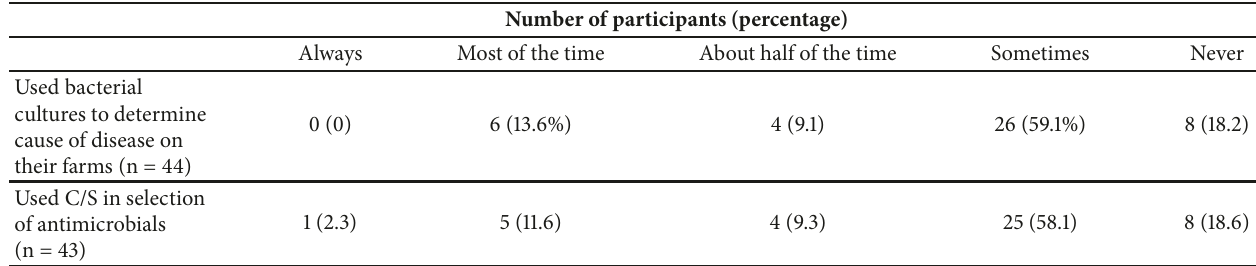
Table 2: Survey results showing the practices of Tennessee dairy producers related to antimicrobial use, 2018. Practice Farm keeps up-to-date written records of antimicrobial drug purchases (n = 40) Farm keeps written records of medicated feeds purchased in the framework of VFD (n = 40) Farm keeps up-to-date written records of antimicrobial drugs used to treat animals (n = 40) Cattle on the farm are sometimes treated with antimicrobials at dosages higher than the label provision (n = 40) Farm practices extra-label AMU (n = 38) Farm has written protocols for treating sick animals with antimicrobials (n = 38)